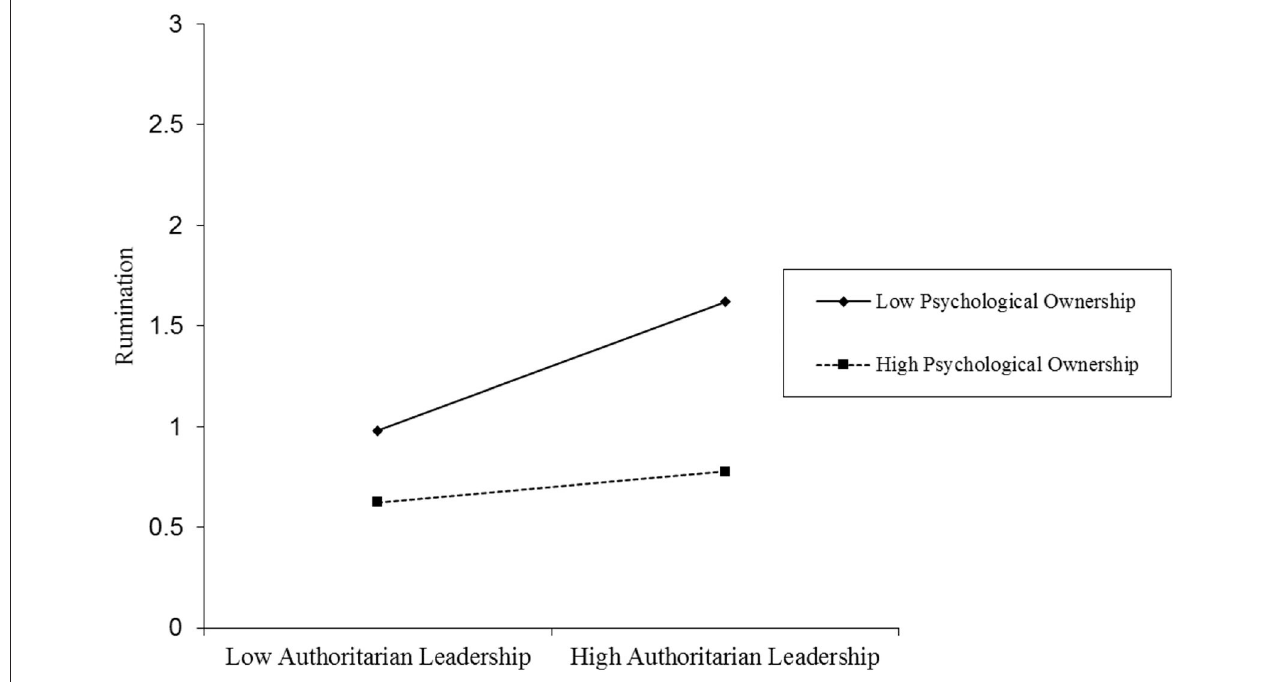
FIGURE 2 | Moderating effect of psychological ownership between the relationship of authoritarian leadership and rumination.